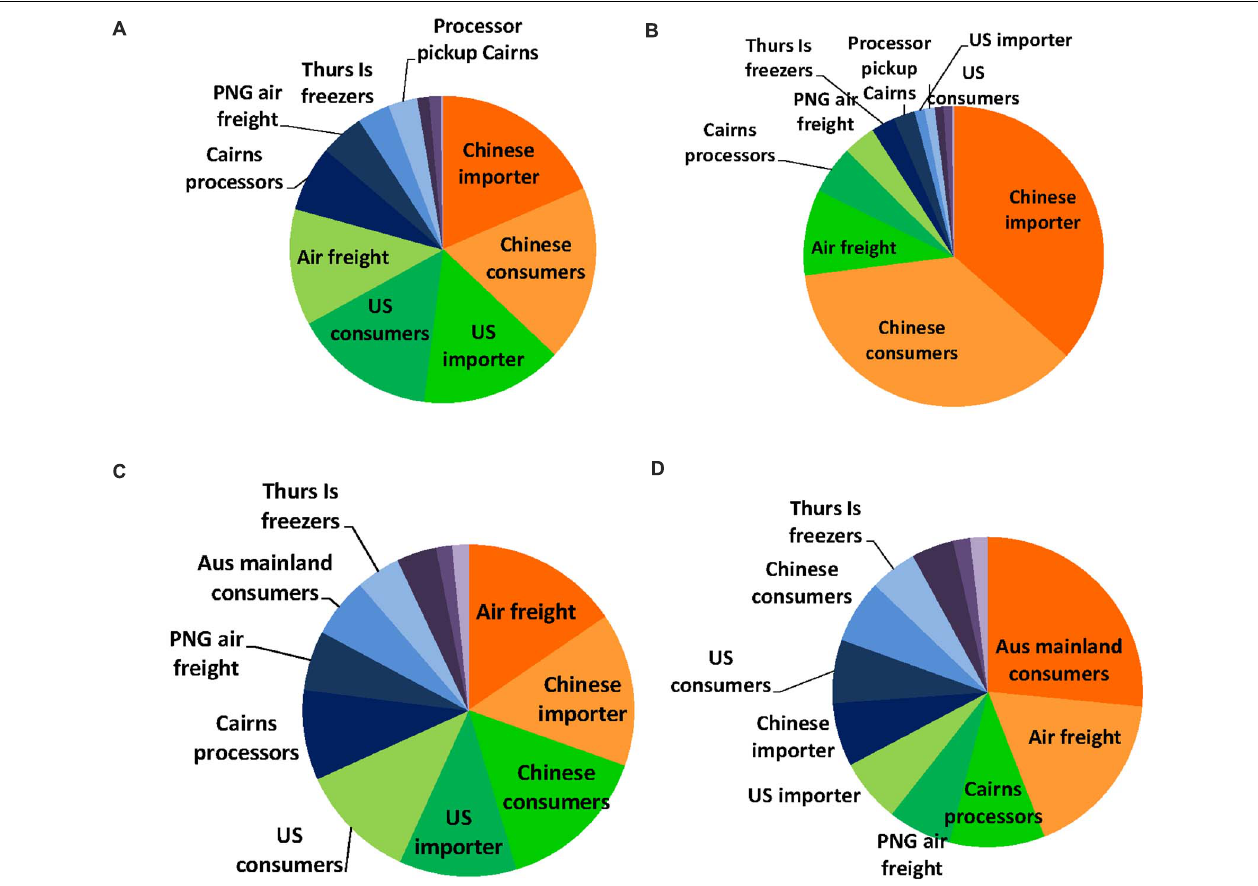
FIGURE 6 | Pie diagrams summarizing the criticality (based on individual Supply Chain Index score of each node) of elements in Tropical Rock Lobster supply chain scenarios: (A) 2012 base-scenario with substantial proportion of product sold as frozen tails, (B) 2019 scenario with very small proportions of tails and few domestic sales, (C) illustrative scenario with larger proportion of product sold on the domestic market, (D) optimized scenario with substantially more product going to domestic market and even split between frozen and live. The size of pie segments represents how critical a node is, and the overall distribution of segments provides an indication of the spread or evenness of the scores attached to different nodes. From highest to lowest scores, the color coding used is roughly red ( >